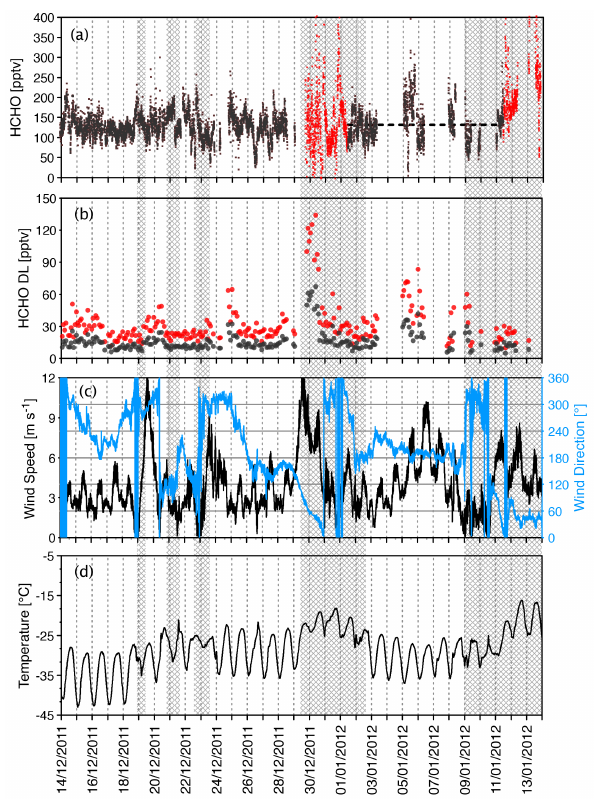
Figure 1. (a) HCHO mixing ratios (time interval of 30s) measured during the 2011/12 OPALE campaign at 1m above the snow sur- face; red points refer to periods during which contamination by wind transport from the station is suspected. The horizontal dashed line indicates the mean mixing ratio observed between 1 and 11 Jan- uary, a period over which the sampling was very discontinuous. (b) Detection limits (DL), taken as 1 and 2 standard deviations of raw zero values measured every 2h. (c) Wind speed and direc- tion. (d) Air temperature. Grey bands denote periods during which clouded sky conditions